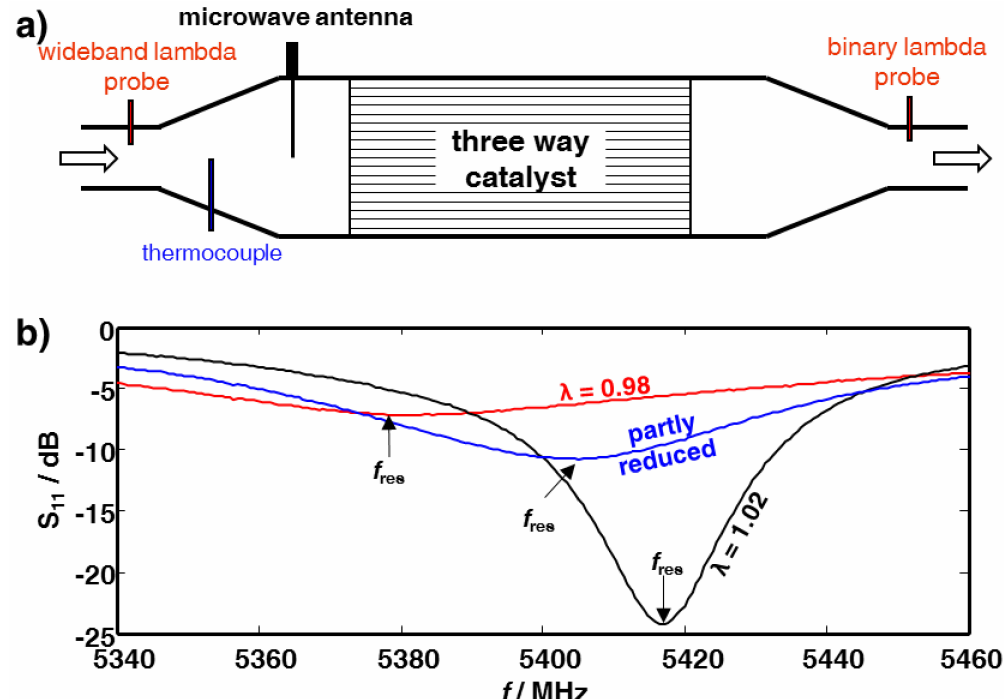
Figure 1. ( a ) Sketch of the setup. ( b ) Typical resonance spectra in the reduced and in the oxidized state (data: 500 °C, lean: λ = 1.02, rich: λ = 0.98). The resonance frequency is indicated by an arrow. Peak width (FWHM) or reflection parameter at f res were not considered